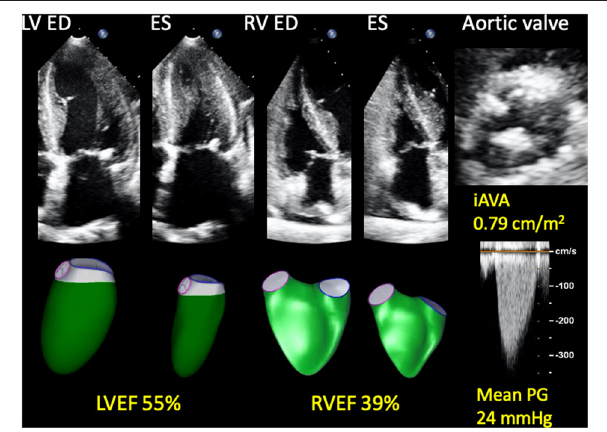
TABLE 1 | Patient characteristics ( n =